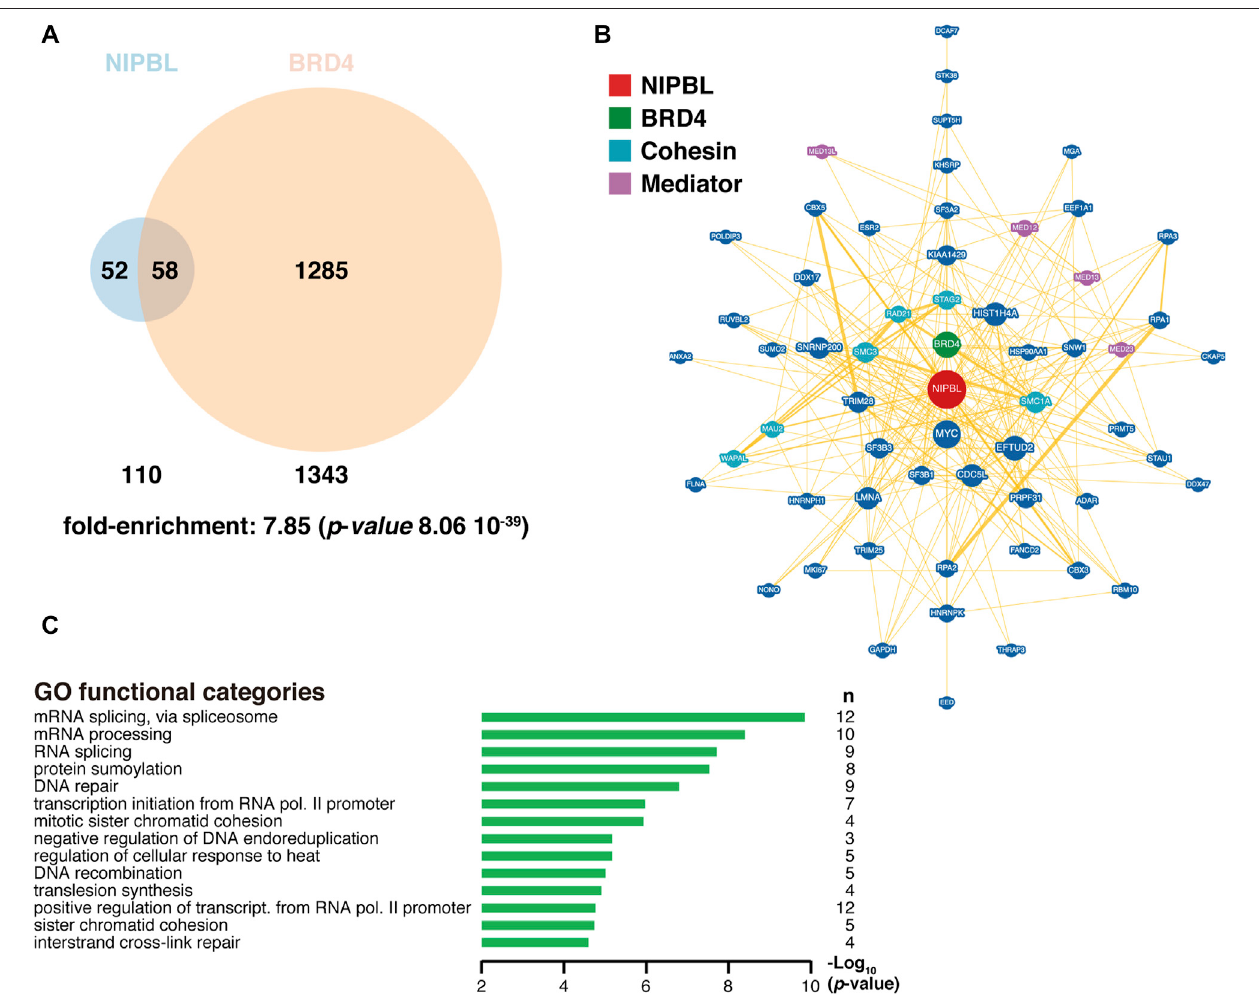
FIGURE3| NIPBLandBRD4interactome. (A) VenndiagramindicatingtheoverlapofNIPBLandBRD4interactors.Fold-enrichmentofcommoninteractorsandits associated p -value from the hypergeometric distribution wasobtained at (https://systems.crump.ucla.edu/hypergeometric/index.php), assuming a total proteome ofat least 100,000 different proteins. Data were obtained from BioGRID (https://wiki.thebiogrid.org/doku.php/tools). Venn diagrams were constructed with the Venny 2.1 tool (https://bioinfogp.cnb.csic.es/tools/venny/) and depicted with Venn Diagram Maker at (https://www.meta-chart.com/venn). (B) Common NIPBL-BRD4 interactome with NIPBL occupying a central position (red). BRD4 is indicated in green, Mediator proteins in purple and cohesin-related proteins in light blue. Data and representation were derived from BioGRID. (C) Gene Ontology (GO) analysis of common interactors was performed with the DAVID tool at (https://david.ncifcrf.gov/ tools.jsp). n, number of genes in each